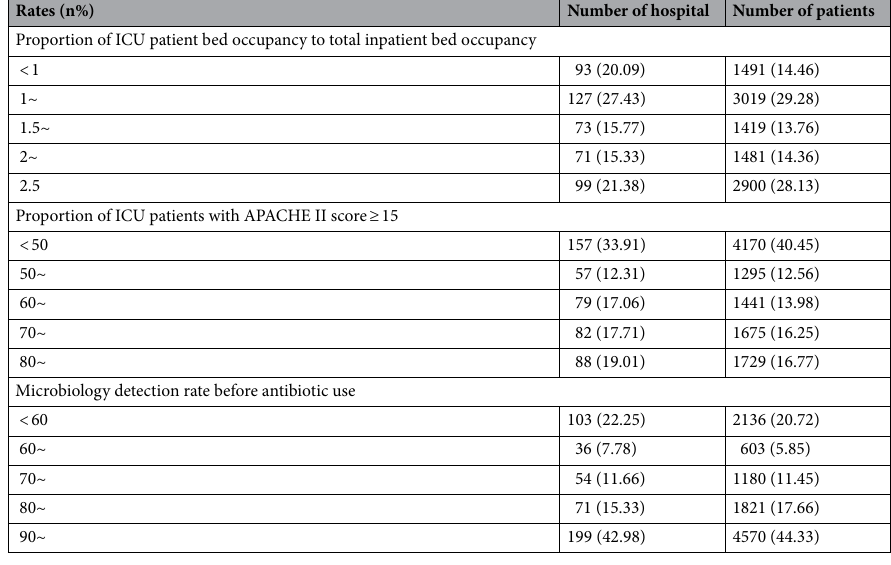
Table 1. Information of quality indicators. ICU, intensive care unit; APACHE, acute physiology and chronic health